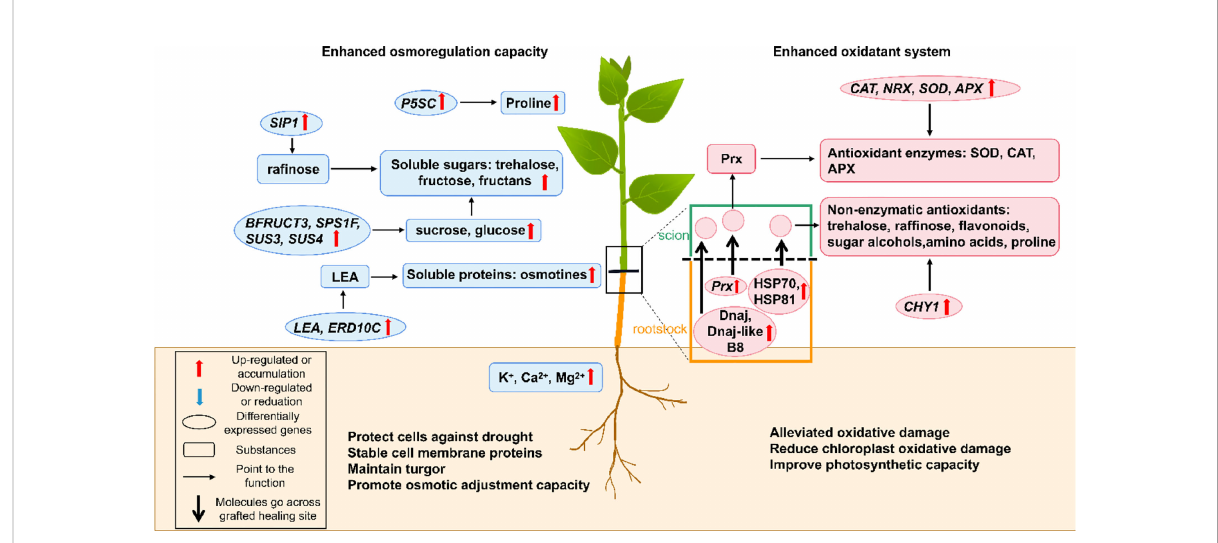
FIGURE 3 A schematic model shows the physiological and molecular mechanisms that enhancing drought resistance by osmoregulation and anti-oxidant system in grafted plants. The green part represents for the scion while the brown part represents for the rootstock. The box shows the fi gure notes. APX, ascorbate peroxidase; BFRUCT3 , b -fructosidase 3 ; CAT, catalase; CHY1 , chloroplast b -carotene hydroxylase ; Dnaj, Chaperone protein DnaJ; Dnaj-like B8, DnaJ-like subfamily B member 8; ERD10C, early responsive to dehydration 10C; GA, gibberellin; HSP70, 70-kDa heat shock protein; HSP81, heat shock protein 81.4; LEA , late embryogenesis abundant protein ; NRX, nucleoredoxin; P5SC , D -1-pyrroline- carboxylate synthase ; Prx , peroxiredoxin ; SIP1 , raf fi nose synthase ; SOD, superoxide dismutase; SPS1F , sucrose phosphate synthase 1F ; SUS3 and 4 , sucrose synthase 3 and 4